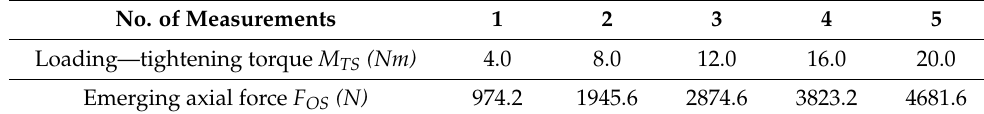
Table 2. Values determined via measurement with lubricant CX80—silicone grease. No. of Measurements